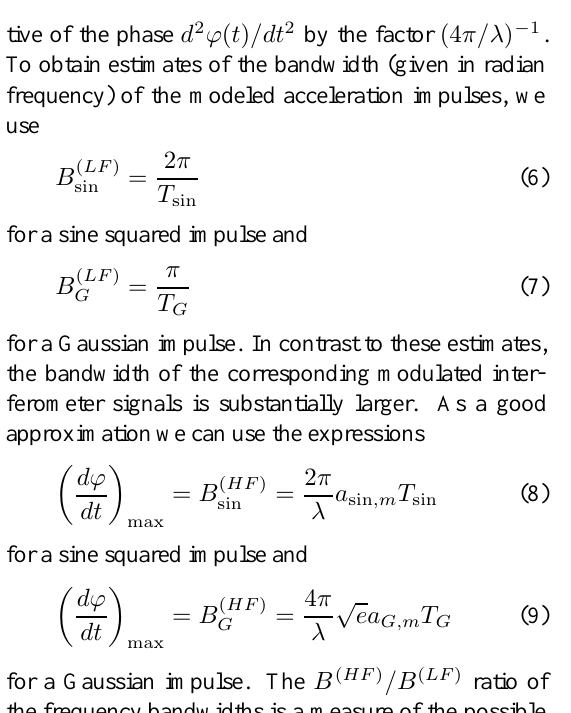
Fig. 1. Signal processing scheme for determining shock sensitivity and complex